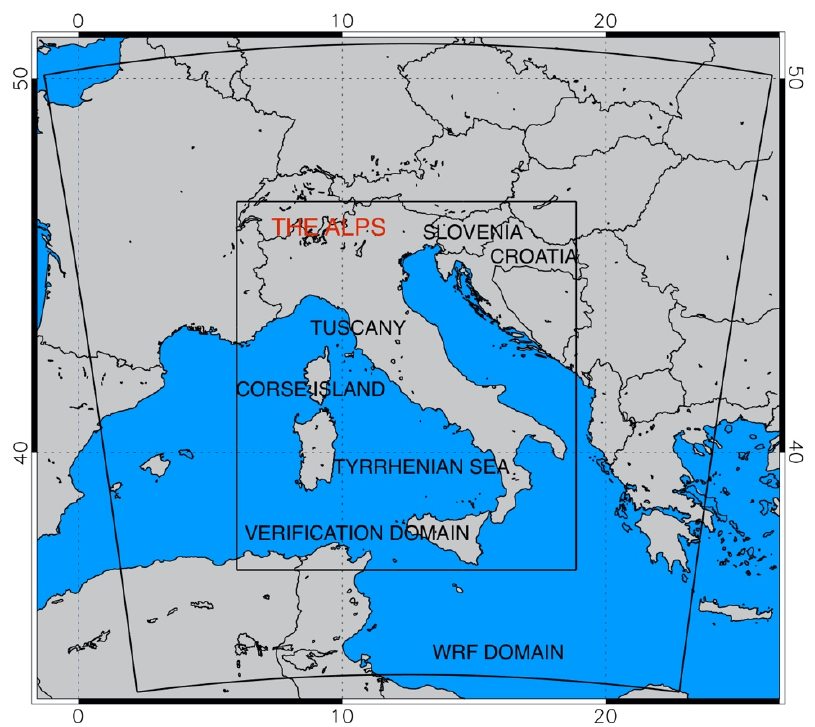
Figure 1. WRF domain and verification area (domain around Italy). Locations cited in the text are also shown.